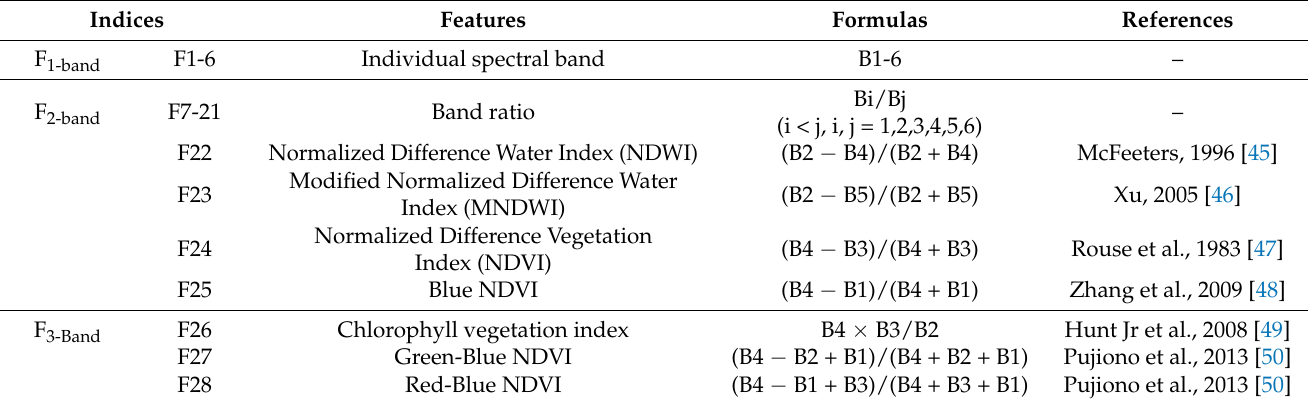
Table 3. List of model input indices, formulas, and